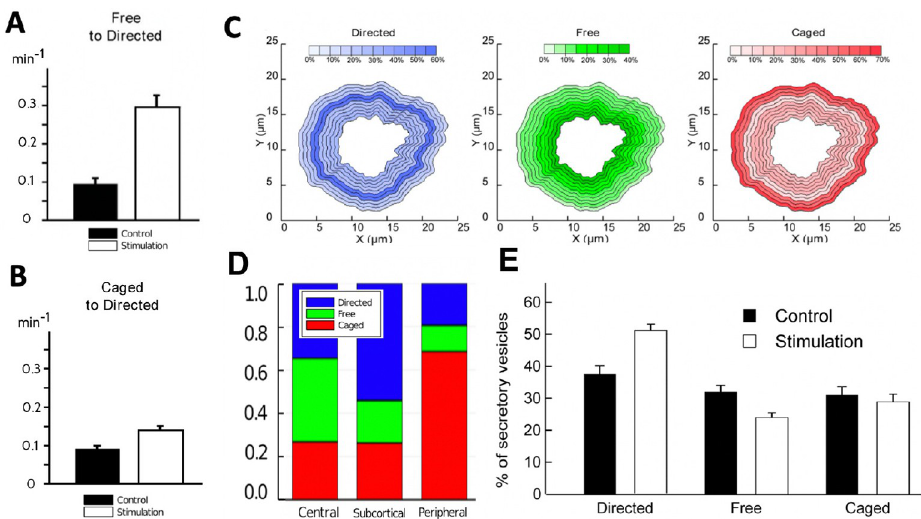
Fig 2. Statistics of tracked vesicles reported in [19]. ( A ) Fig 3H (with rates per 2 min) in [19]: average transition rates from free to directed motile state in control and stimulation. ( B ) Fig 3B (with rates per 2 min) in [19]: average transition rates from caged to directed motile state in control and stimulation. ( C ) Fig 2C in [19]: Proportions of vesicle motile behaviour in spatial bands of radial width 0.5 μ m. ( D ) Data in Fig 2C from [19] averaged within the three spatial compartments. ( E ) Fig 1E in [19]: Percentages of secretory vesicles in each motile state in control and stimulation.